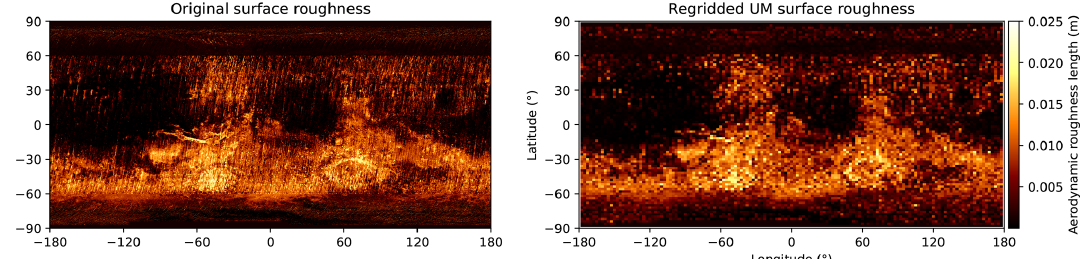
Figure 4. Surface roughness map from Hébrard et al. (2012) (left) and how it is represented in the UM after regridding